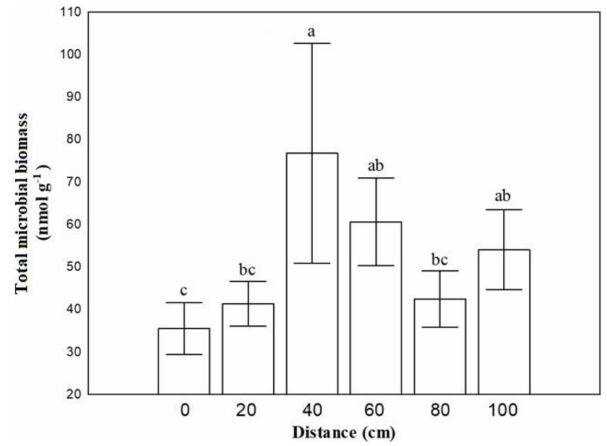
Figure 1. Mean values ( ± SE) of soil microbial biomass at 0, 20, 40, 60, 80 and 100cm distance, respectively, from the trunk of Er- ica spp. The letters a, b, c and d indicate the significant differences between distances revealed by a least squares distance (LSD)